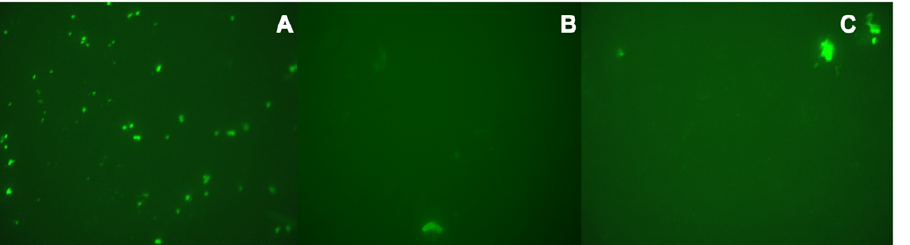
Figure 4. Analysis of HX2 outer surface localization on S.suis HA9801. Oil immersion fluorescence microscopy ( 6 1,000) was conducted on S. suis HA9801 bacteria labeled with rHX2 antiserum (panel A), control rabbit serum (panel B), and PBS negative control (panel C); IgG-FITC was the